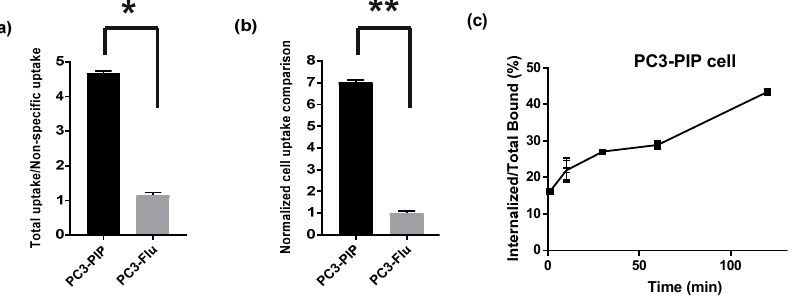
Figure 2. In vitro cell assays of [ 18 F]F-TZ(PSMA)-LEGU-TLR7. ( a ) Total cell uptake vs. nonspecific uptake of [ 18 F]F-TZ(PSMA)-LEGU-TLR7 in the absence and presence of Lys-Urea-Glu (1 mM). ( b ) Normalized PSMA specific uptake (no blocking) of [ 18 F]F-TZ(PSMA)-LEGU-TLR7 (the uptake change in PC-3-Flu cells was set at 1.0). ( c ) Internalization of [ 18 F]F-TZ(PSMA)-LEGU-TLR7 in PSMA + PC3-PIP cells. Data presented as average counts ± s.d. ( n = 3). * p = 0.0004, ** p = 0.0004 (unpaired t-tests performed by GraphPad Prizm 7.04).